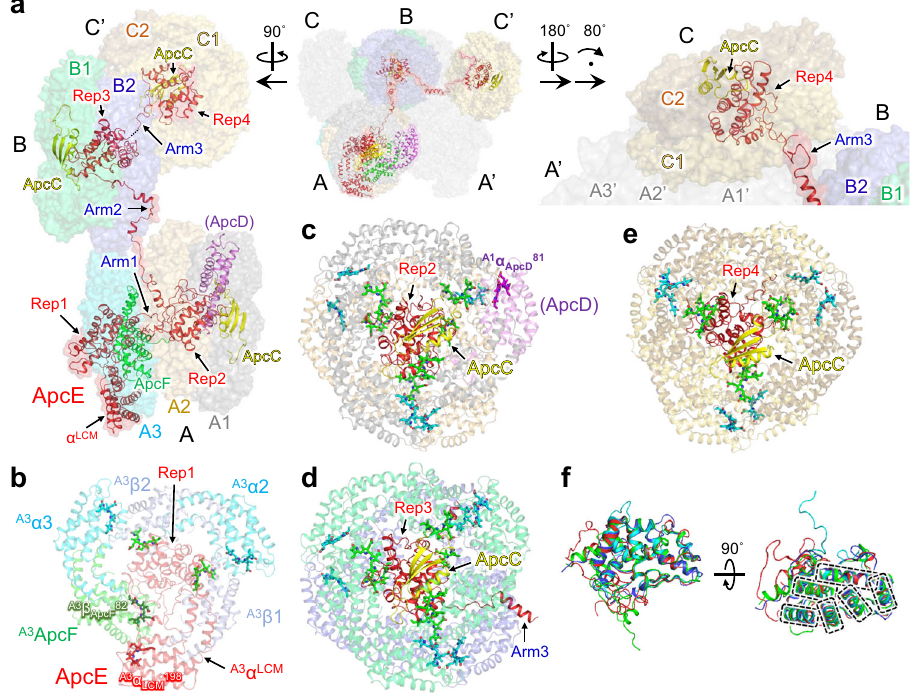
Fig. 2 Structures of A, B, and C cylinders, including terminal emitters and linker proteins. a Arrangement of the terminal emitters ( α LCM of ApcE [L CM ] and ApcD), ApcF, and linker proteins (ApcE [L CM ] and ApcCs). b Structures of APC trimer (A3) and Rep1 of ApcE (L CM ) in A cylinder. c Structures of APC trimers A1 and A2, ApcC, and Rep2 of ApcE (L CM ) in A cylinder. d Structures of APC trimers B1 and B2, ApcC, Rep3, and Arm3 of ApcE (L CM ) in B cylinder. e Structure of APC trimers C1 and C2, ApcC, and Rep4 of ApcE (L CM ) in C ’ cylinder. f Superposition of four Rep structures (Reps1 – 4). Dashed lines indicate the α -helixes in the Rep regions. Rep1, green; Rep2, red; Rep3, blue; Rep4,